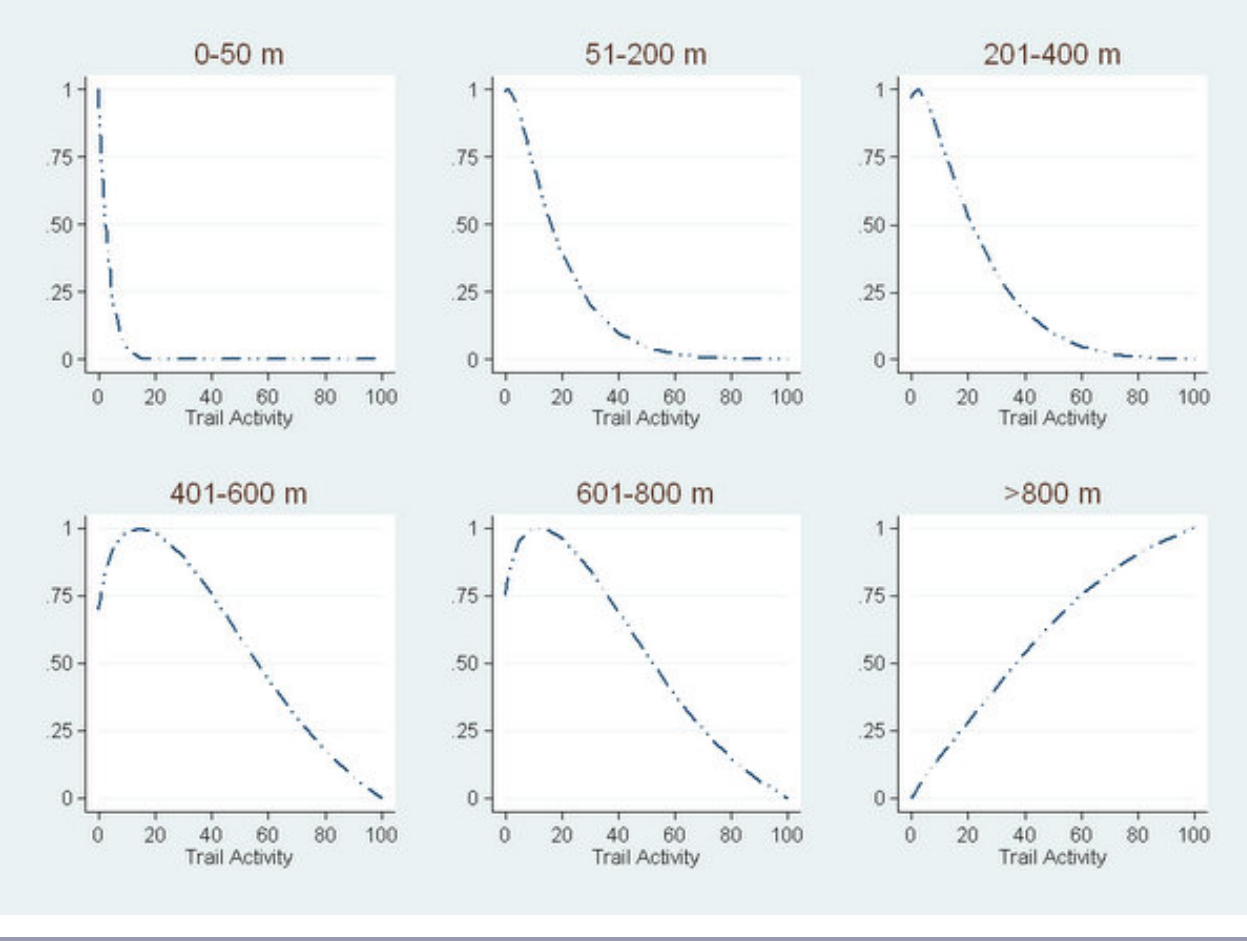
Fig. 4. Graphs of the change in elk relative probability of use as a function of increasing trail activity within six ‘distance-to-trail’ categories. The x-axis is hourly trail activity and y-axis is relative probability of use. A linear stretch was used to scale the predicted values between 0 and 1 following Johnson et al.